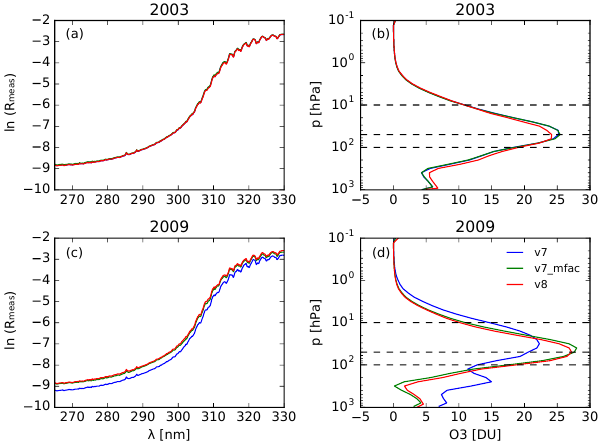
Figure 4. Integrated degrees of freedom for signal (DFS) from bot- tom to each level of SCIAMACHY ozone profile retrievals for in- dividual months for nadir states in the tropics between 15 ◦ N and 15 ◦ S. The levels are marked for one of the profiles in the top-left panel with horizontal ticks. The DFS profiles are shown for two years: 2003 in solid lines and 2009 in dashed lines. Here L1 v8 is